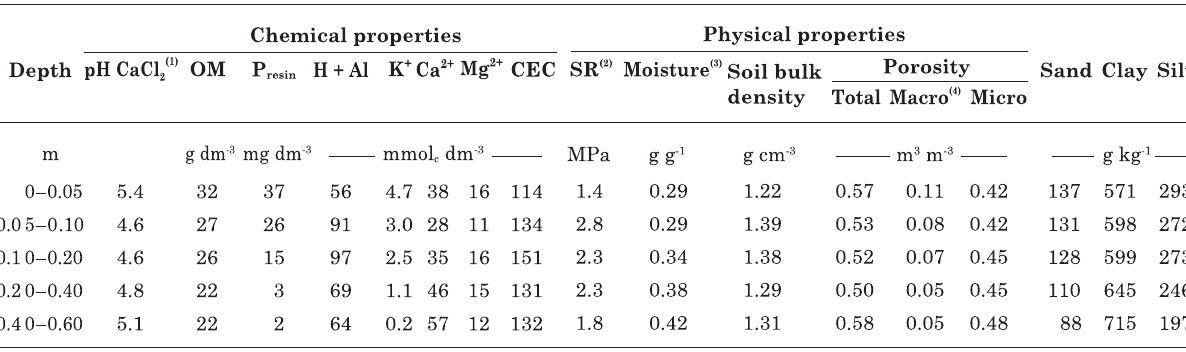
Table 1. Chemical and physical properties of the soil in the experimental